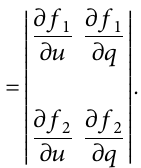
Figure 3: Schematic diagram of the static test. (a) The static test of three magnet pairs. (b) The static test of a single magnet pair. (c) The static test of linear springs. (d) The static test curve of magnet sets. (e) The static test curve of linear springs. (f) The static test curve of the NSA. (g) The static test of the